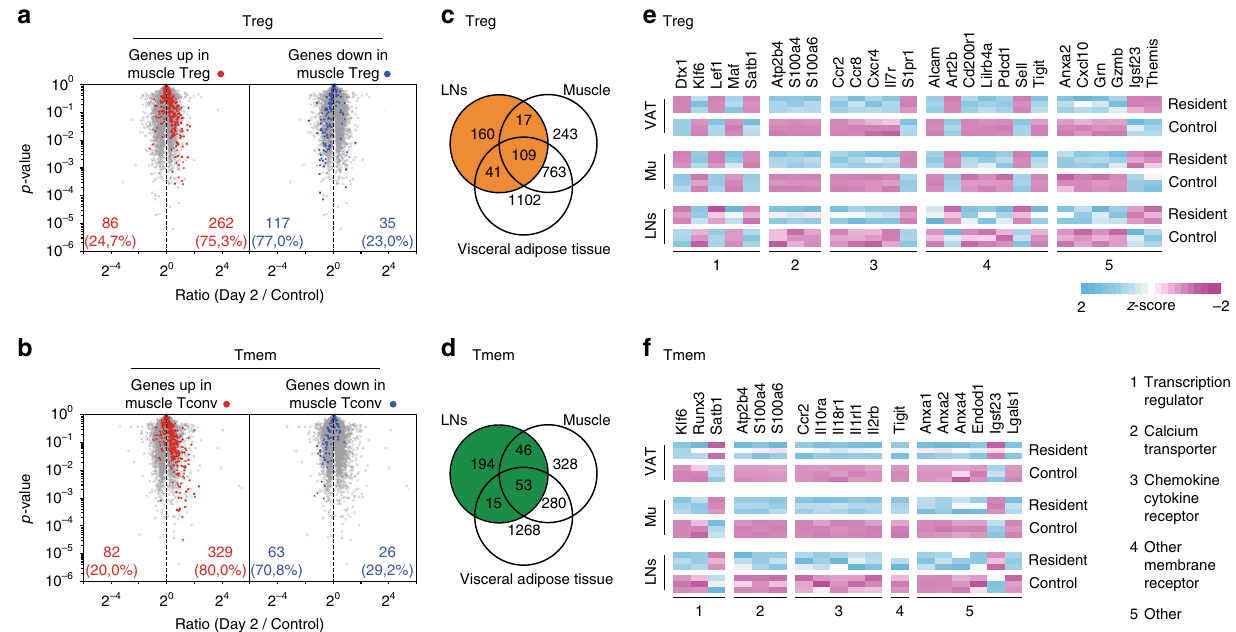
Fig. 6 Gene expression pro fi ling of LN-resident CD4 Treg and Tmem cells. a “ Volcano plot ” representation (Log 2 (ratio) versus Log 10 ( t test p value)) between day 2 and control LN CD4 Treg cells from C57BL/6 Foxp3-GFP mice. Among the 500 genes the most differentially expressed between muscle and control CD4 Treg cells with a P value of < 0.05, upregulated and downregulated genes are highlighted in red and blue respectively. Data sets were fi ltered to common probes between the two arrays. b Same as in a for CD4 Tmem cells. c Comparison of the sets of genes differentially expressed between day 2 LN, Muscle and VAT CD4 Tregs cells and their respective control cells. Data sets were fi ltered to common probes between the three arrays. d Same as in c for CD4 Tmem cells. e Expression pattern of chosen genes differentially expressed ( ± 1.5 fold change, with a p value of < 0.05) between day 2 LN, Muscle and VAT CD4 Tregs cells and their respective control cells. f Same as in e for CD4 Tmem